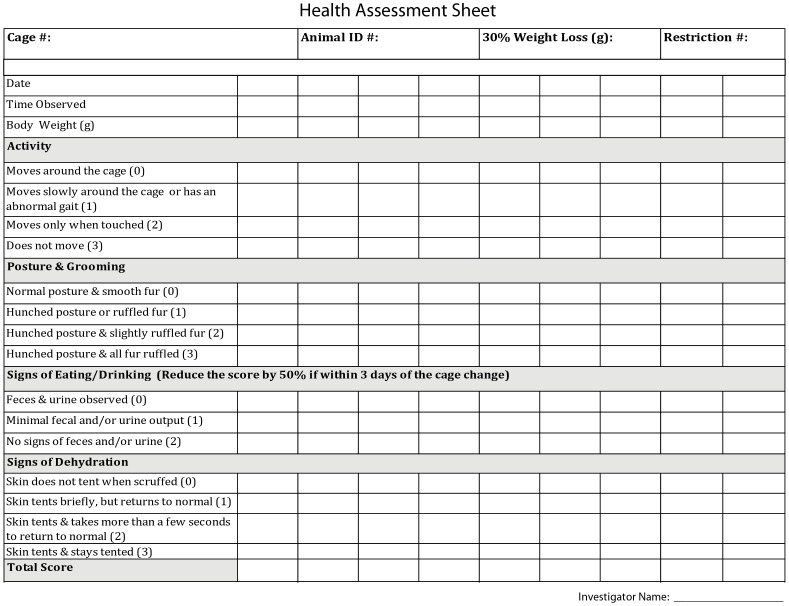
Mice with one or more indicators of stress or pain are placed on detailed health assessment.Activity levels, grooming, and indicators of eating and drinking are scored daily in a health assessment sheet. The total aggregate health score determines if mice are supplied with additional water (see flowchart in Figure 2).